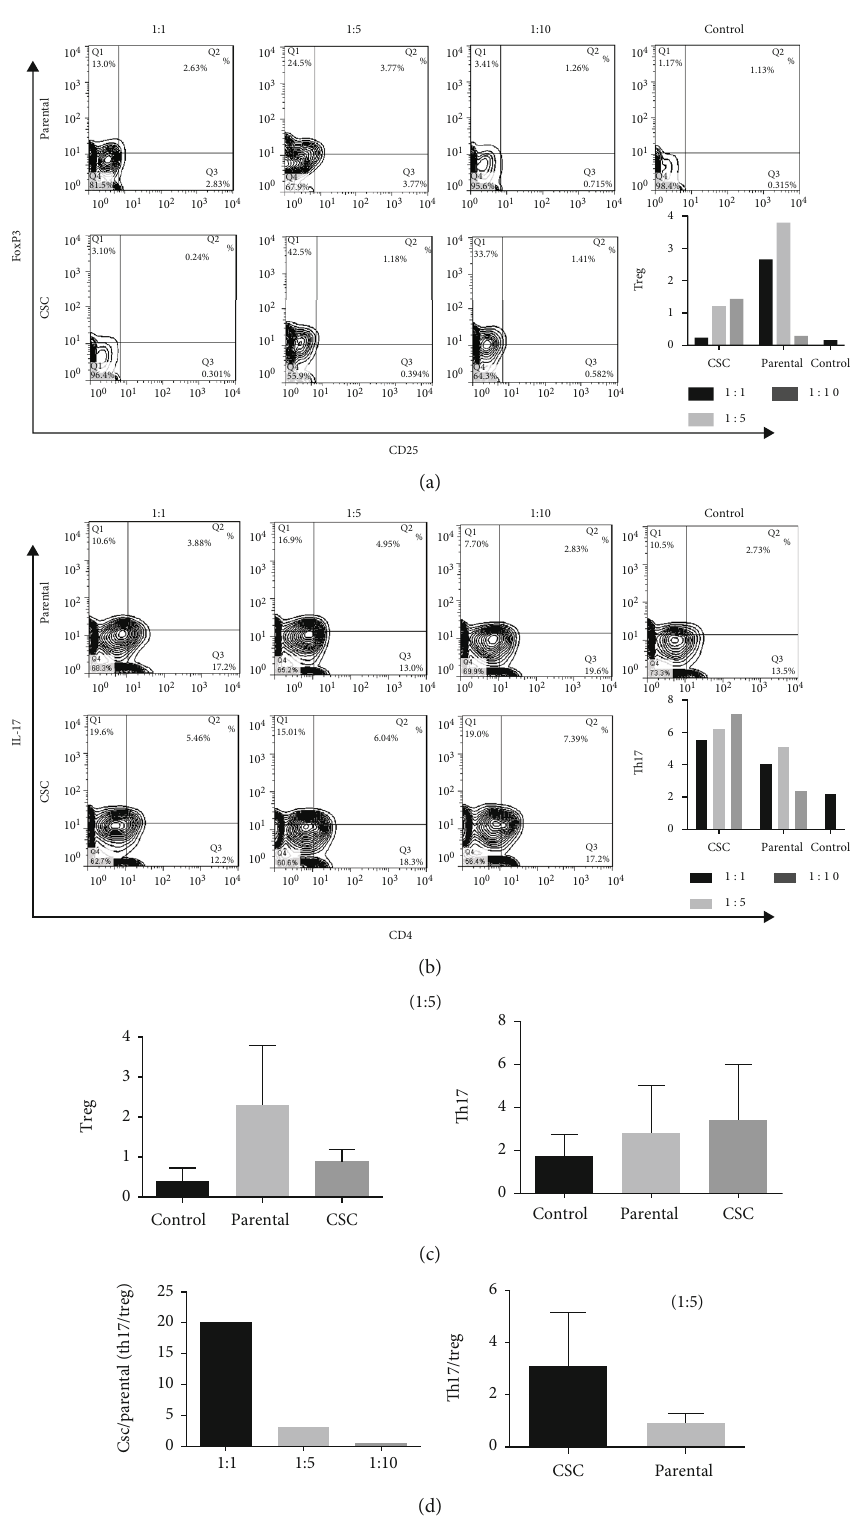
Figure 2: Di ff erentiation of Th17 and Treg in exposure to parental cells and gastrosphere-derived condition media in MLR. (a, c) CD4 + CD25 + FoxP3 + Treg cell di ff erentiation after exposure to gastrospheres or parental-derived condition media. (b, c) CD4 + IL-17 + Th17 cell di ff erentiation after exposure to gastrospheres or parental-derived condition media. (d) The ratio of Th17 to Treg after exposure to gastrospheres or parental-derived condition media. CSC: gastrospheres. Data are mean ± SD of three independent